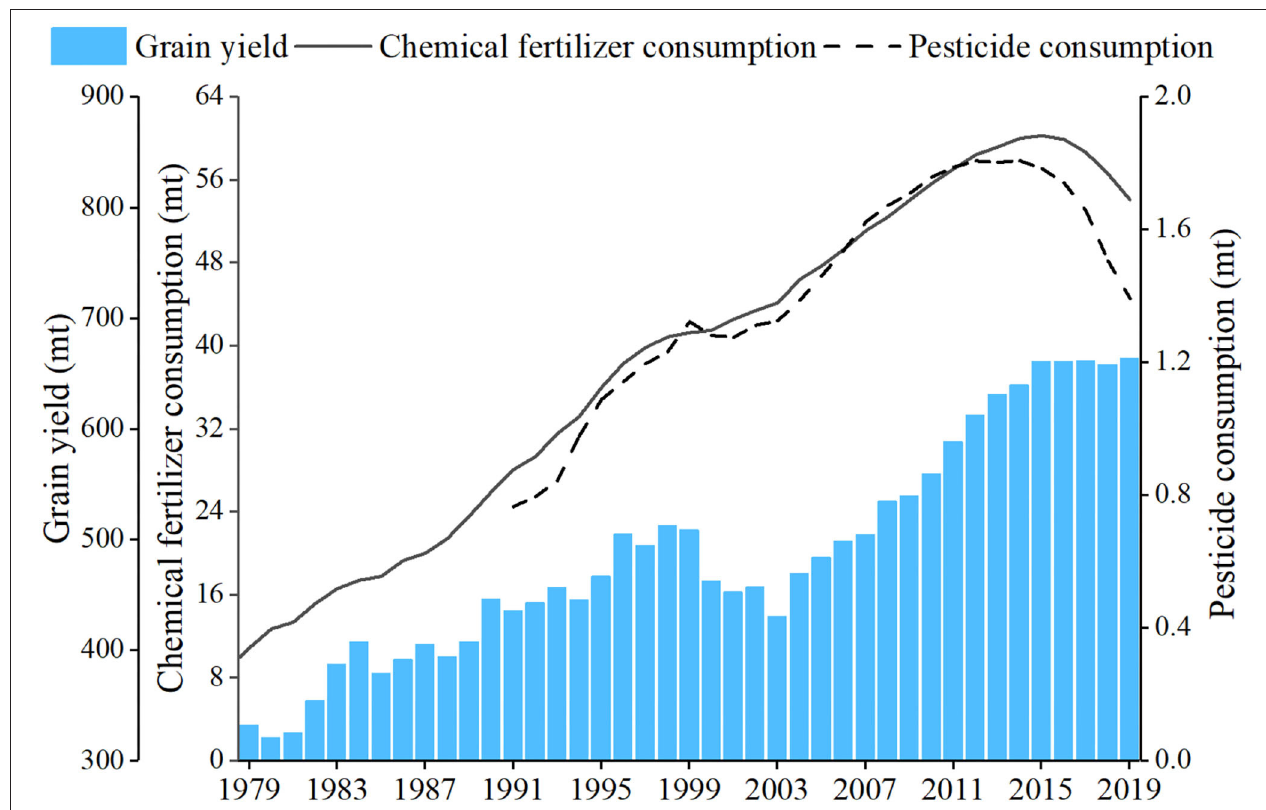
FIGURE 1 | The grain yield and fertilizer and pesticide consumption. Data source: